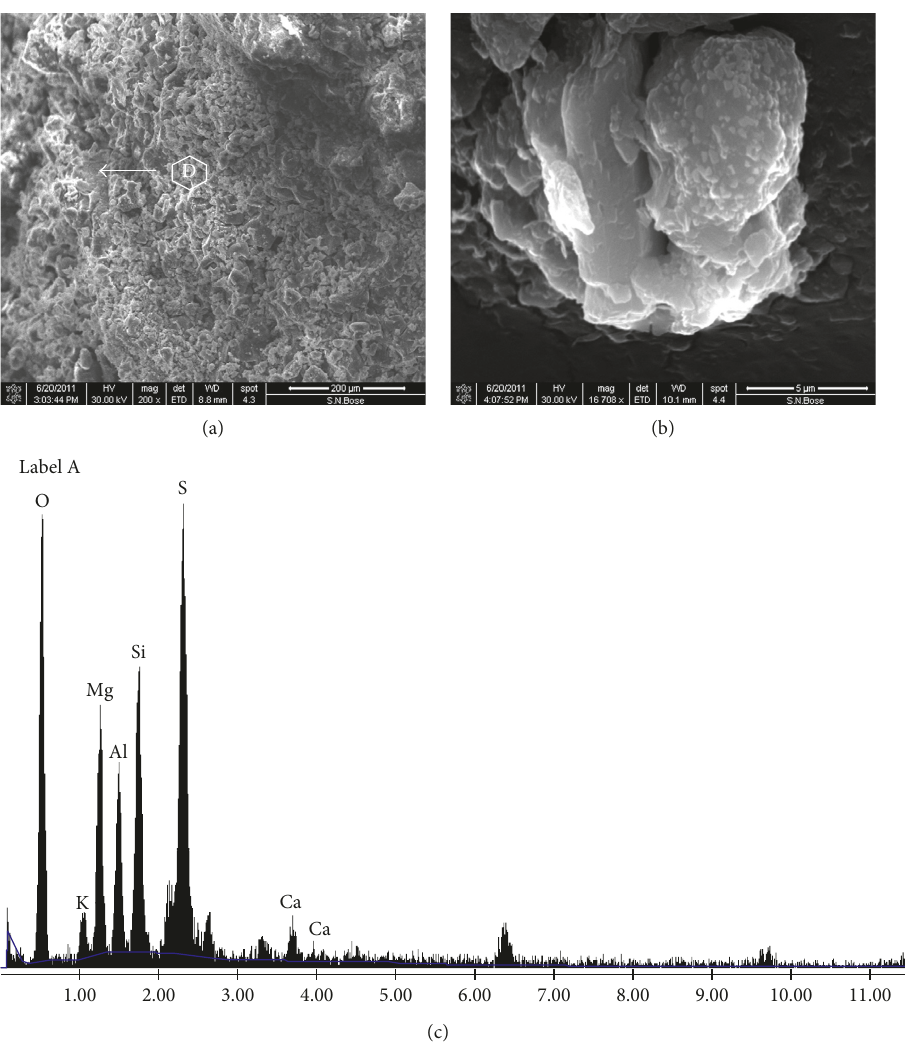
Figure 10: (a) Sample SMF1 showing white precipitant at the inner surface after 3 months at 200x magnifications. (b) SEM analysis near point D at 16708x magnification. (c) EDAX analysis at point